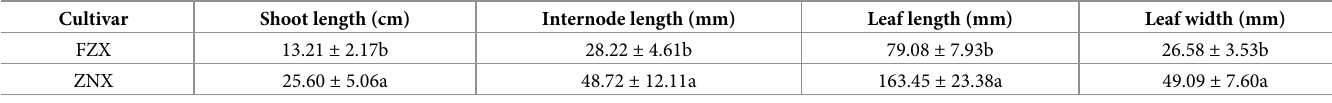
Table 1. Comparasion of shoot and leaf length between ZNX and FZX. Cultivar